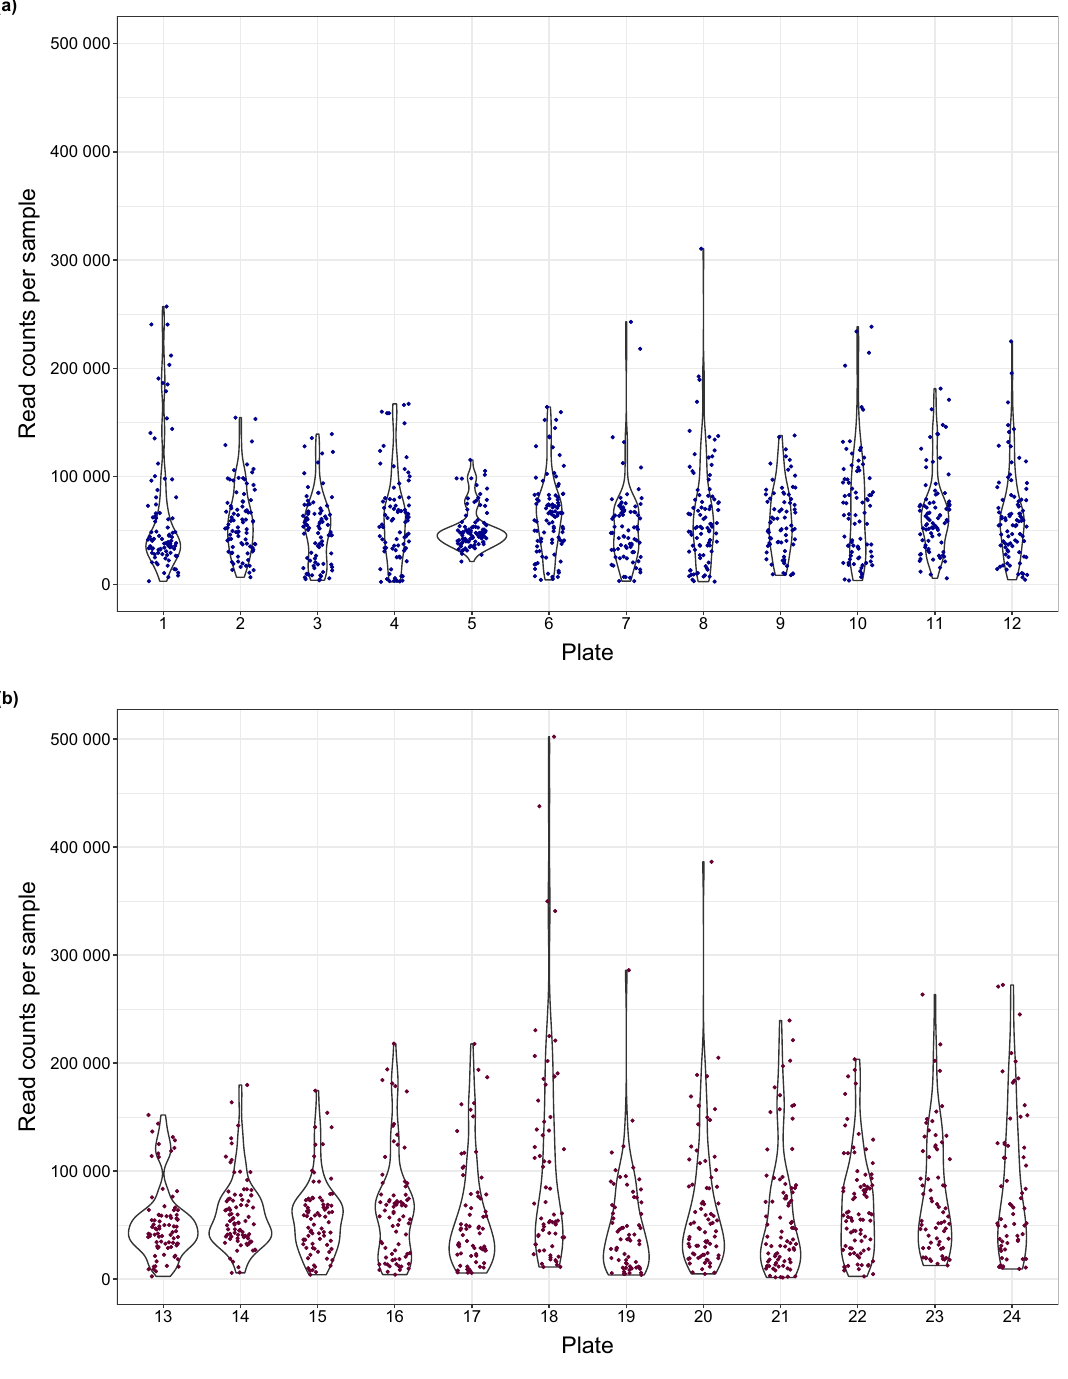
Figure 3. Read counts per sample after adapter trimming, shown for the plates ( a ) 1 to 12 of lane 1 and ( b ) 13 to 24 of lane 2, dots represent the individual dietary samples in lane 1 (n = 1028) and lane 2 (n =